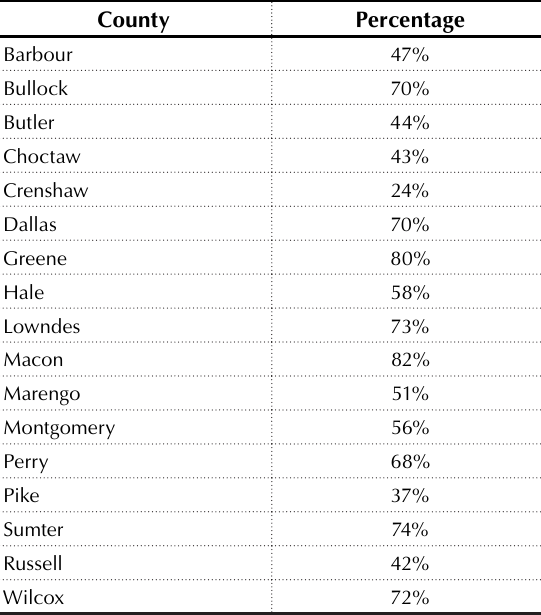
Table 1. Traditional Black Belt counties and percentage of